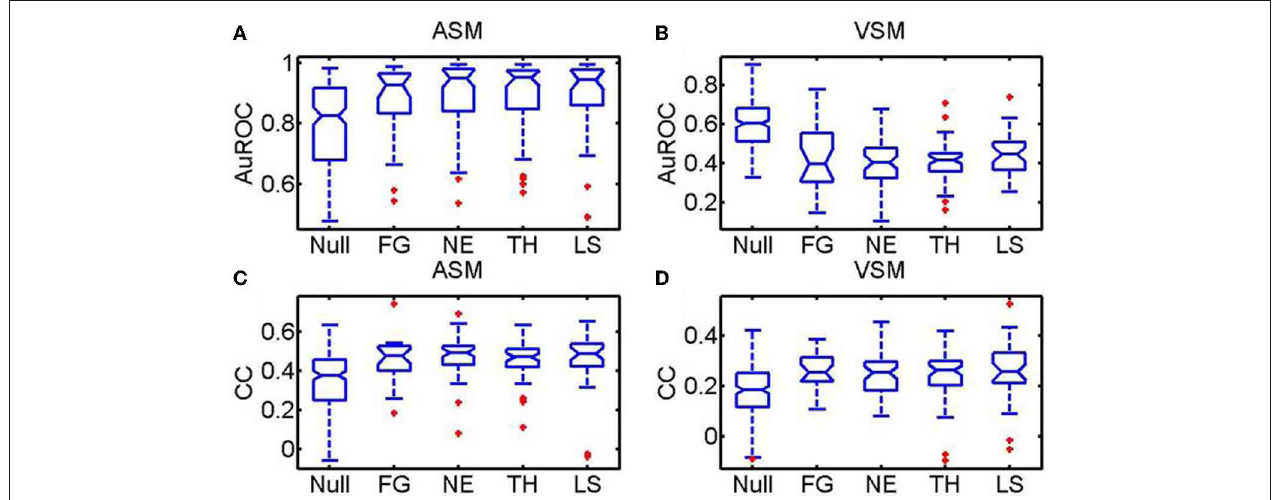
( A and B ) bottom-up saliency, as defined by Itti and Koch, is a relatively good predictor of fixations on landscapes and objects but it is systematically below chance for faces. Ensemble bursting in the primates’ amygdala is an excellent predictor of fixations over faces regardless of facial expression. As happens with the AuROC, the ASM correlates (CC) significantly better ( p f , < 0.01, Kruskall–Wallis) with the fixation map for faces than for non-faces. However, no significant differences exist in the prediction of the fixation patterns across the different facial expressions ( p e < 0 . 1,